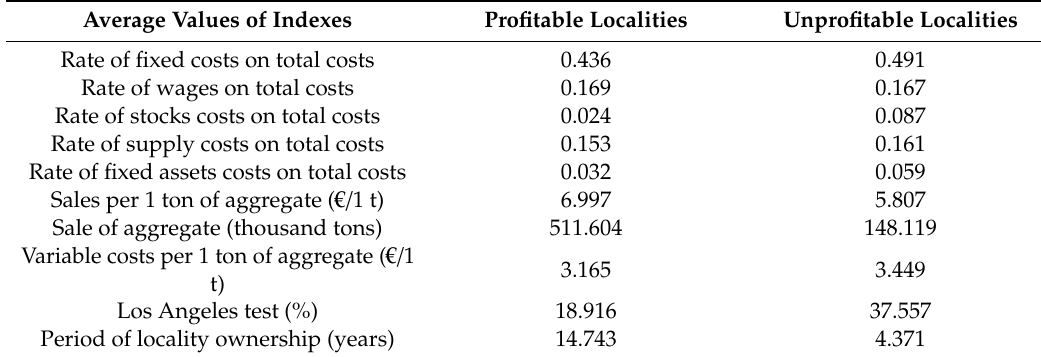
Table 3. Average values of